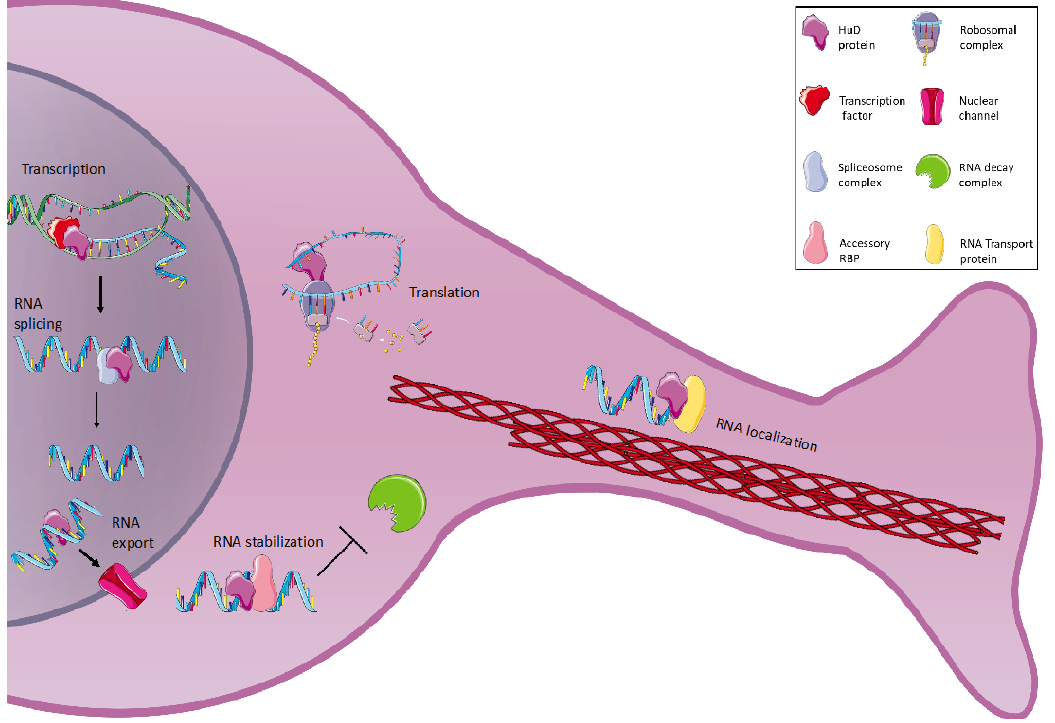
Figure 2. Schematic representation of HuD roles in neurons. In the nucleus, HuD cooperates with transcription factors for RNA synthesis, it is involved in RNA splicing through interaction with spliceosome complex, and it promotes mRNA export to the cytoplasm through nuclear pores. In the cytoplasm, HuD is involved in mRNAs translation and, in cooperation with other RBPs, it prevents mRNAs degradation and controls specific mRNA localization in neuronal compartments. This figure was drawn using the vector image bank of Servier Medical Art (https://smart.servier.com/). Table 1. HuD target transcripts. The table shows a list of known HuD target transcripts. In the “Function” column, + indicates upregulation and – indicates